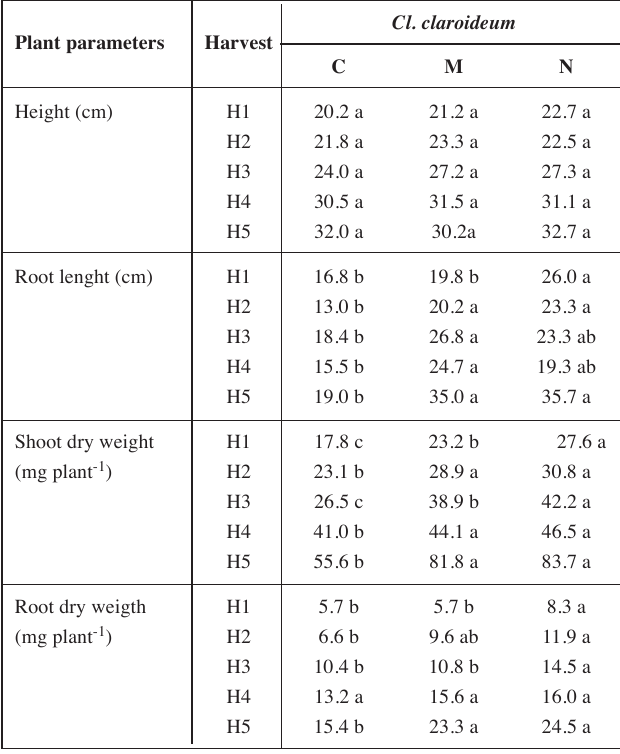
Plant growth parameter increased over time (Tab. 2). While plant height was not influenced by NP, root length, shoot dry weight and root dry weight increased through NP already from the second harvest on.